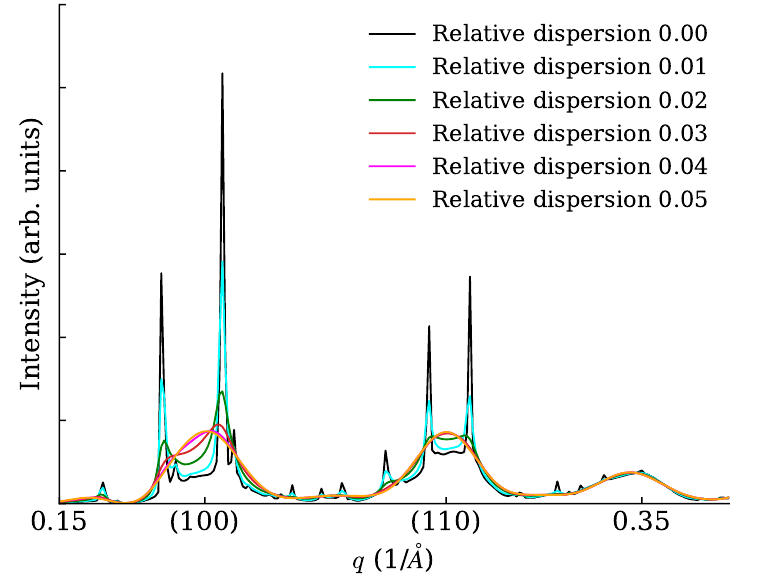
Figure 6. XRPD scattering from a plate (2D SC) with various levels of relative SL spacing